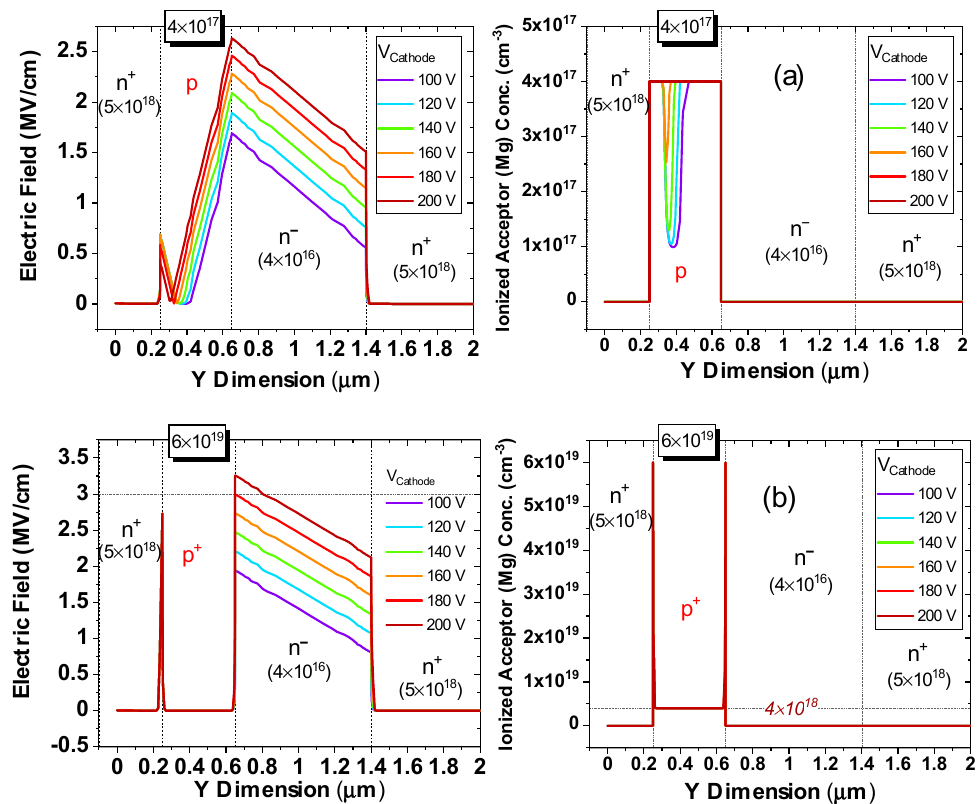
Figure 12. Electric field profile and ionized Mg acceptor concentration for simulations at different voltages with the incomplete ionization model: ( a ) low p-doping, N A = 4 × 10 17 cm − 3 , ( b ) high p-doping, N A = 6 × 10 19 cm − 3 . A trade-off exists on the value of p-doping: it must be sufficiently low to reduce the peak field, and sufficiently high to avoid punch-through.